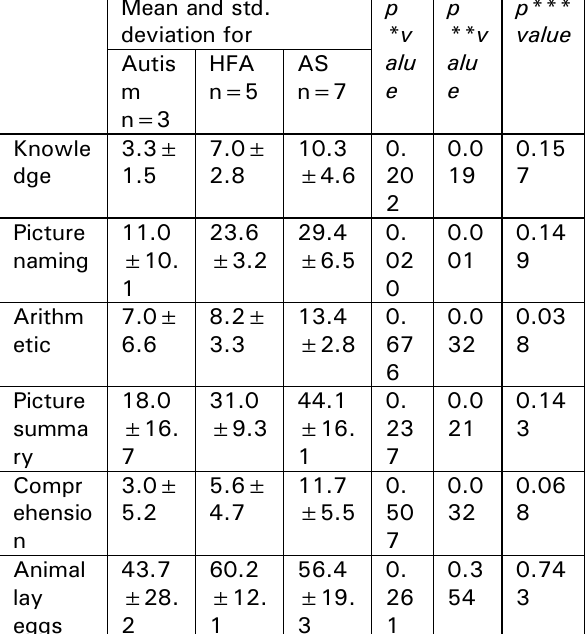
Table 3: C-WYCSI between Autism, HFA and AS